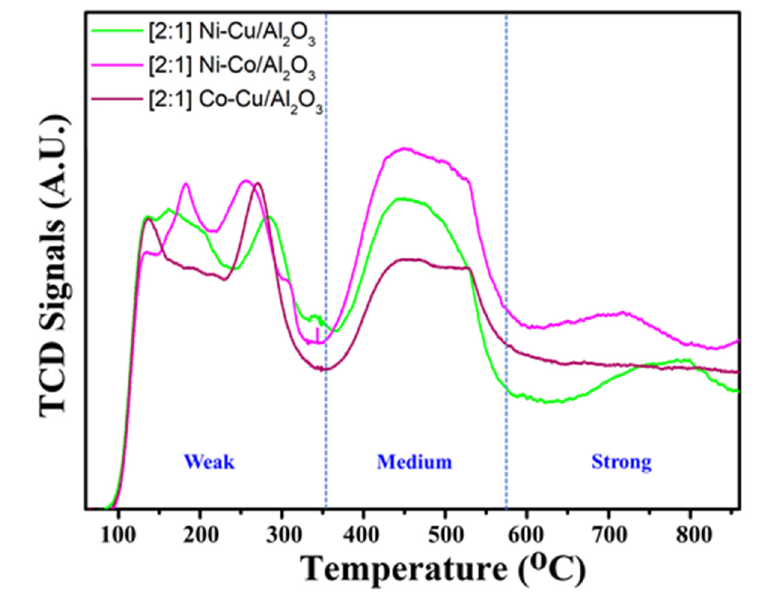
Figure 7. The NH 3 -TPD patterns of the selected bimetallic catalysts.